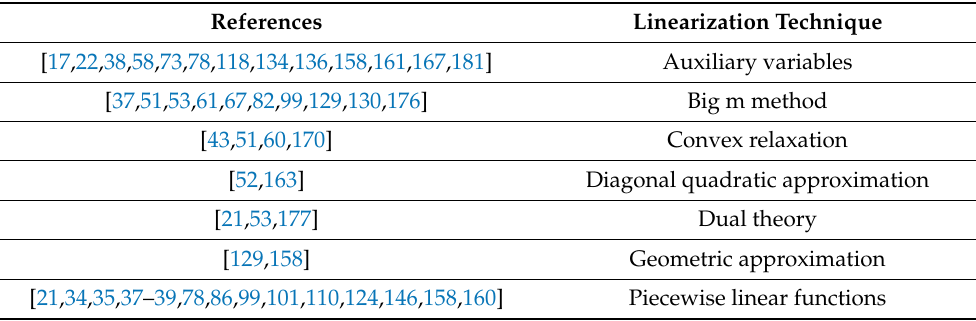
Table 14. Linearization techniques employed in the DGS literature.